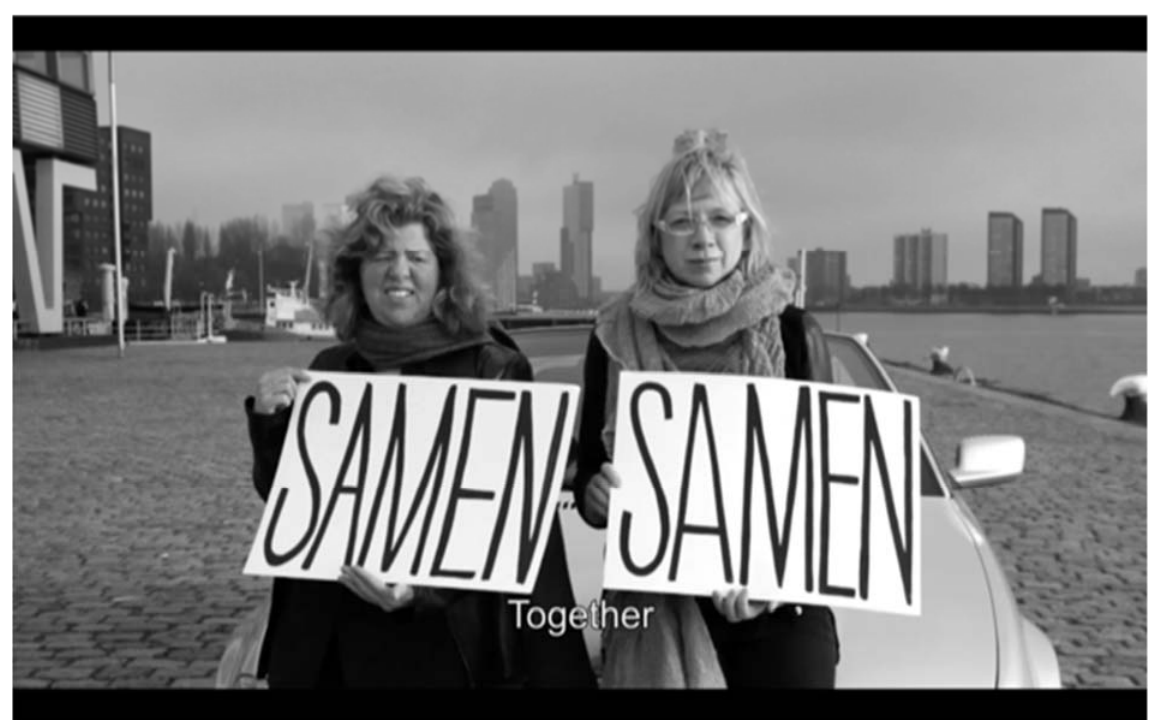
Figure 1. Inclusive research duo.